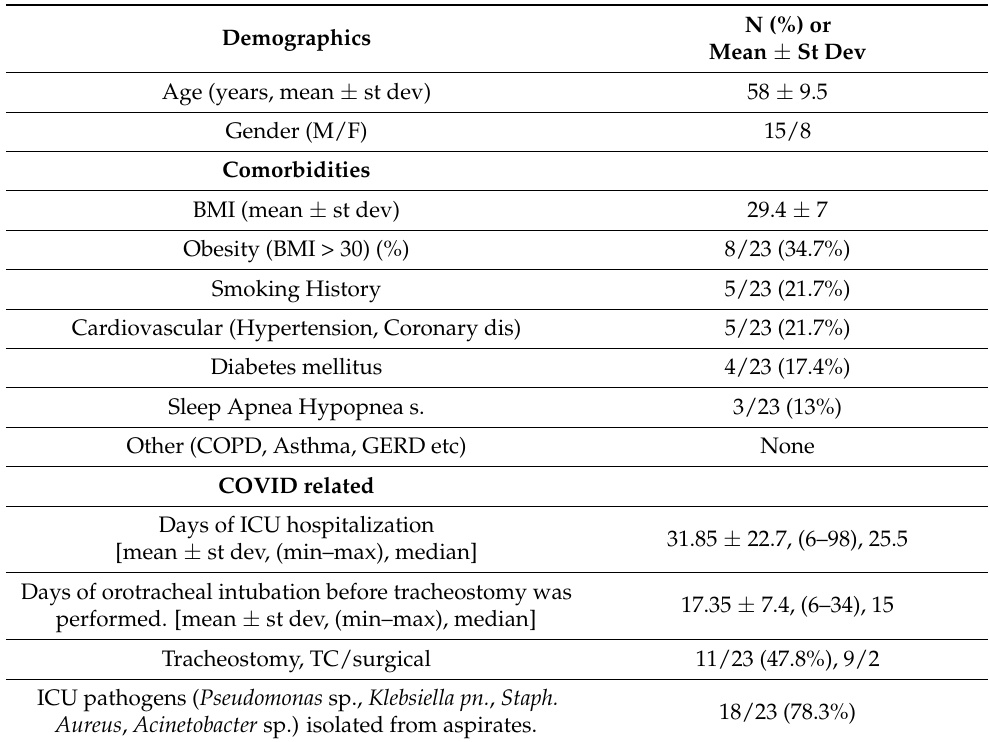
Table 1. Patients’